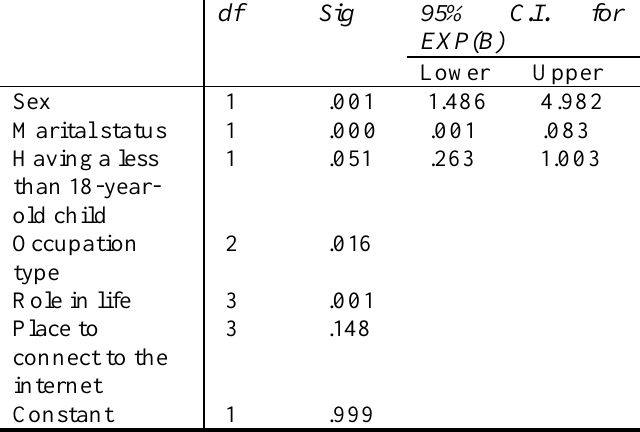
Logistic Regression Results To Predict Potential Relationship Between Confounding Variables and Persistence